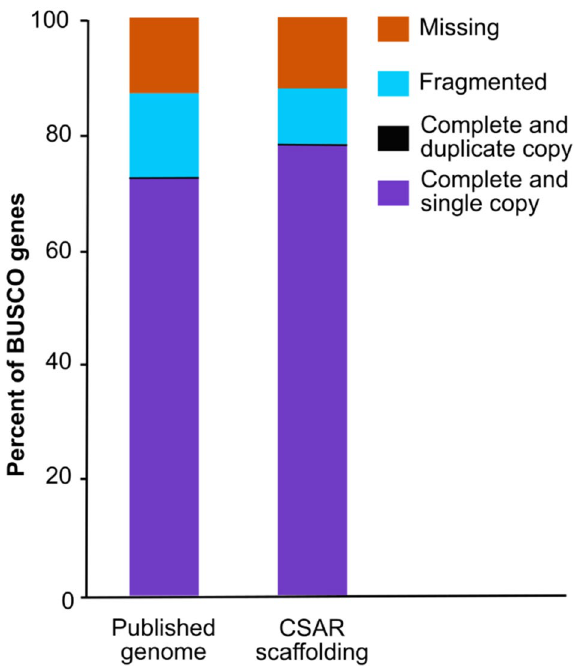
Figure 2. BUSCO (Benchmarking set of Universal Single-Copy Orthologues) analysis of two A. dauci genome assembly. Percentage of completeness was based on the Pezizomycotina gene dataset of BUSCO. Published genome: Genome of A. dauci strain BMP0167 available on Alternaria genome database 55 . CSAR scaffolding: assembly of the published genome helped by FRA001 transcriptome data obtained in this